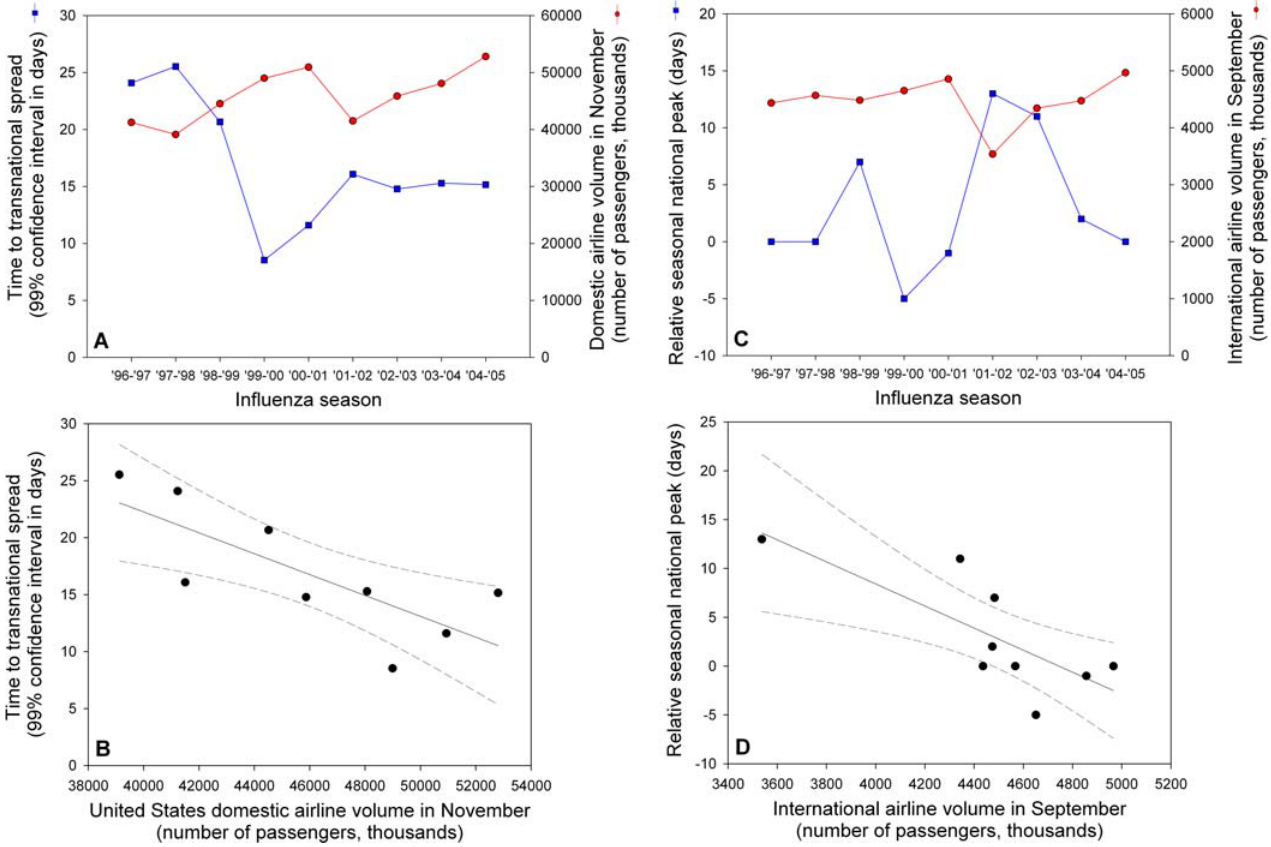
Figure 4. Influence of United States Airline Volume on Influenza Spread and the Timing of Yearly Transmission (A) November domestic air travel volume (red line) is estimated by the total number of passengers on domestic flights. Duration to transnational spread of influenza (blue line) is estimated as the 99% confidence intervals for differences between the estimated seasonal curves of influenza mortality for each of nine major geographic regions of the United States. (B) The association between domestic airline travel in November and transnational spread is displayed. The numbers of traveling domestic passengers in November significantly predicts transnational influenza spread ( f ¼ 10.6; r 2 ¼ 0.60; slope ¼(cid:1) 0.94 days/million passengers; p ¼ 0.014). (C) September international air travel volume (red line) is estimated by the total number of passengers on international flights. The timing of seasonal national influenza mortality (blue line) is estimated as the peak date of influenza mortality from the filtered national curve. The timing displayed is relative to the average date of February 17. (D) The association between international airline travel in September and the timing of the US influenza peak is displayed. The numbers of traveling international passengers in September significantly predicts the timing of seasonal influenza mortality ( f ¼ 10.0; r 2 ¼ 0.59; slope ¼(cid:1) 11.3 days/million passengers; p ¼ 0.016). DOI: